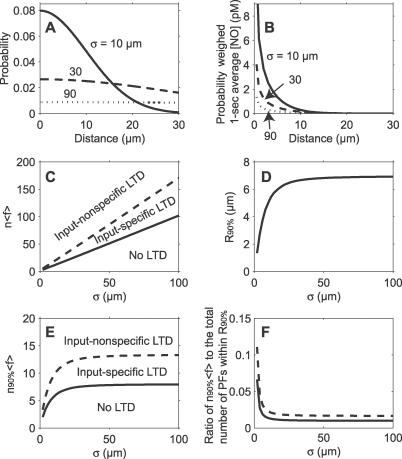
Prediction of PF Activity In VivoThe spatial distribution of the PFs responsible for a certain movement in a certain context was assumed to follow a Gaussian distribution with a standard deviation of σ.(A) The occurrence of the PFs responsible for a particular motion in a particular context was assumed to follow a Gaussian distribution,
. σ is either 10 μm (solid line), 30 μm (dashed line), or 90 μm (dotted line).
(B) The probability-weighed time-averaged NO concentration,
, is plotted against R. σ is either 10 μm (solid line), 30 μm (dashed line), or 90 μm (dotted line).
(C) Against σ, this panel plots the n<f> at which [P-AMPAR]50%,19min of AMPARs in a stimulated synapse (solid line) or in a neighboring unstimulated synapse (dashed line) was phosphorylated at 19 min.(D) R90%, which satisfies
, is plotted against σ.
(E) n90%<f> (see Results for explanation) is plotted against σ. Solid line, stimulated synapse; dashed line, neighboring unstimulated synapse.(F) The ratio of n90%<f> to the total number of the PFs projecting within R90% μm of the dendritic plate is plotted against σ. Solid line, stimulated synapse; dashed line, neighboring unstimulated synapse.